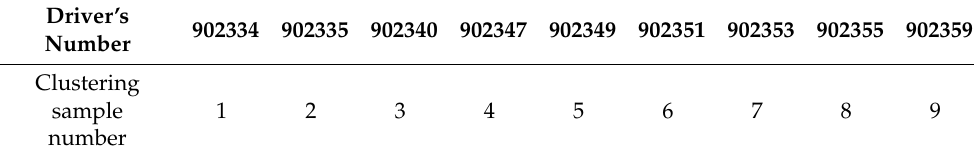
Table 1. Driver’s number and corresponding clustering sample number.